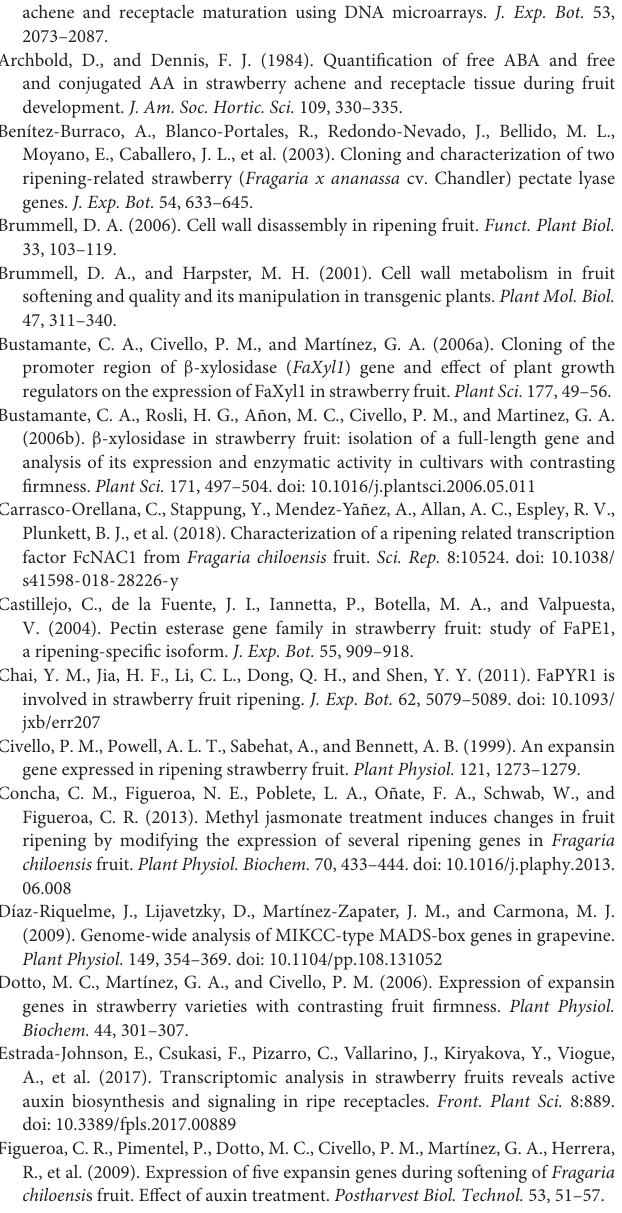
Figueroa, C. R., Pimentel, P., Gaete-Eastman, C., Moya, M., Herrera, R., Caligari, P. D. S., et al. (2008). Softening rate of the Chilean strawberry ( Fragaria chiloensis ) fruit reflects the expression of polygalacturonase and pectate lyase genes. Postharvest Biol. Technol. 49, 210–220. Figueroa, C. R., Rosli, H. G., Civello, P. M., Martínez, G. A., Herrera, R., and MoyaLeón, M. A. (2010). Changes in cell wall polysaccharides and cell